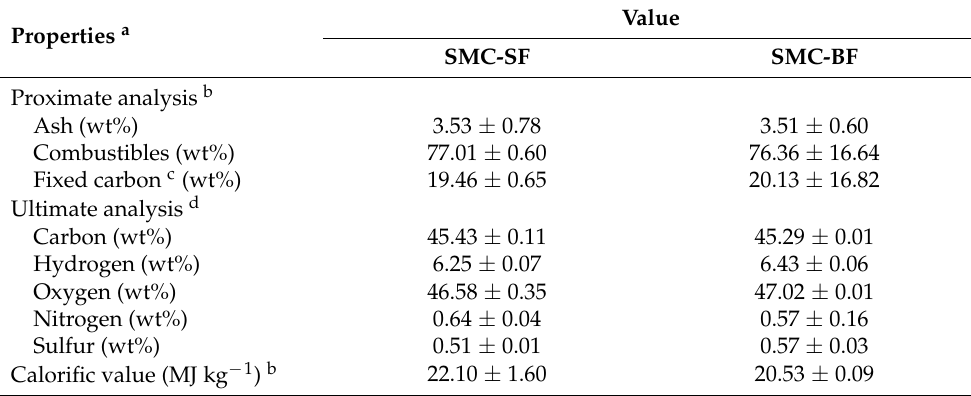
Table 1. Thermochemical properties of spent mushroom composts